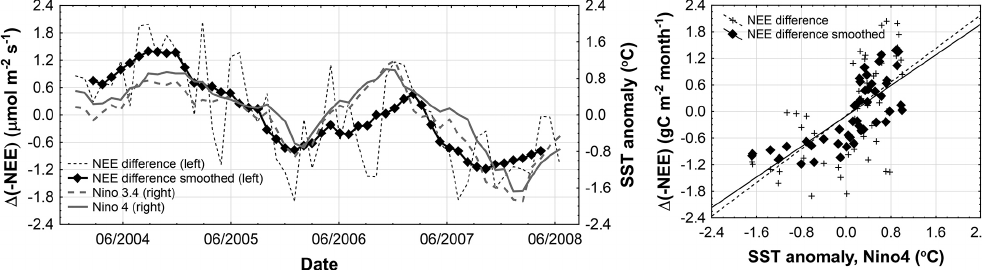
Figure 6. Comparisons of interannual patterns of SST anomalies in Nino4 and Nino3.4 zones of the equatorial Pacific with variability in both deviations and 7-month ( ± 3 months) moving average deviations of midday NEE (10:00–14:00WITA) values from mean monthly midday values of NEE averaged over the entire measuring period from 2004 to 2008.